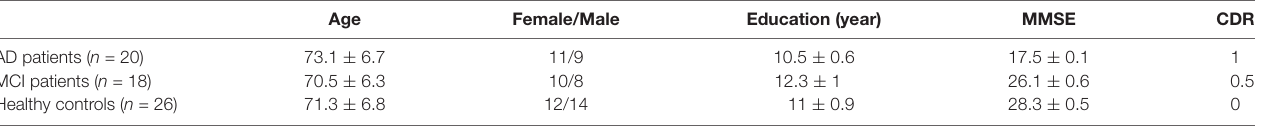
TABLE 1 | Demographics of Alzheimer’s disease (AD) and mild cognitive impairment (MCI) patients, and healthy controls